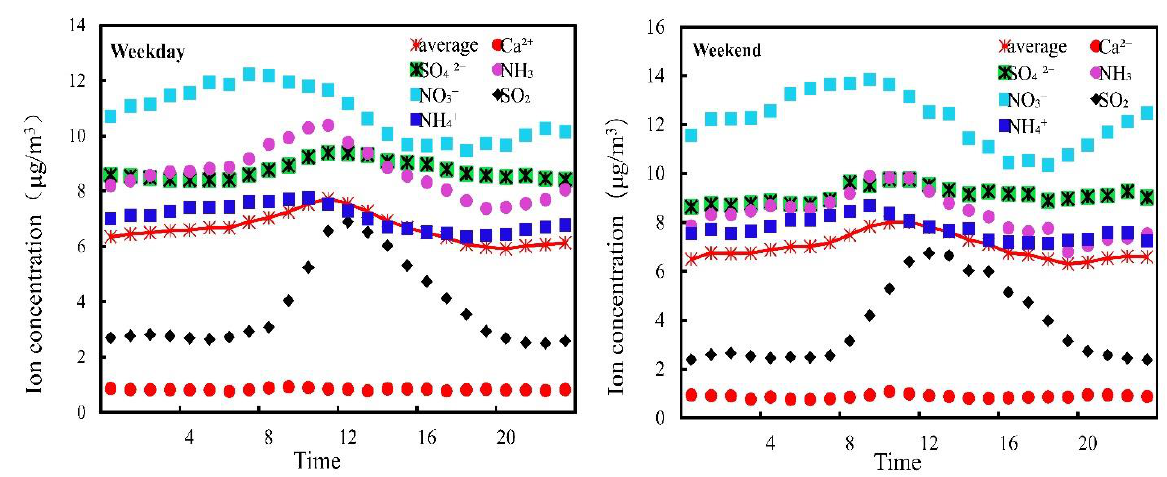
Figure 4. Changes in the concentrations of water-soluble ions on weekdays and weekends.